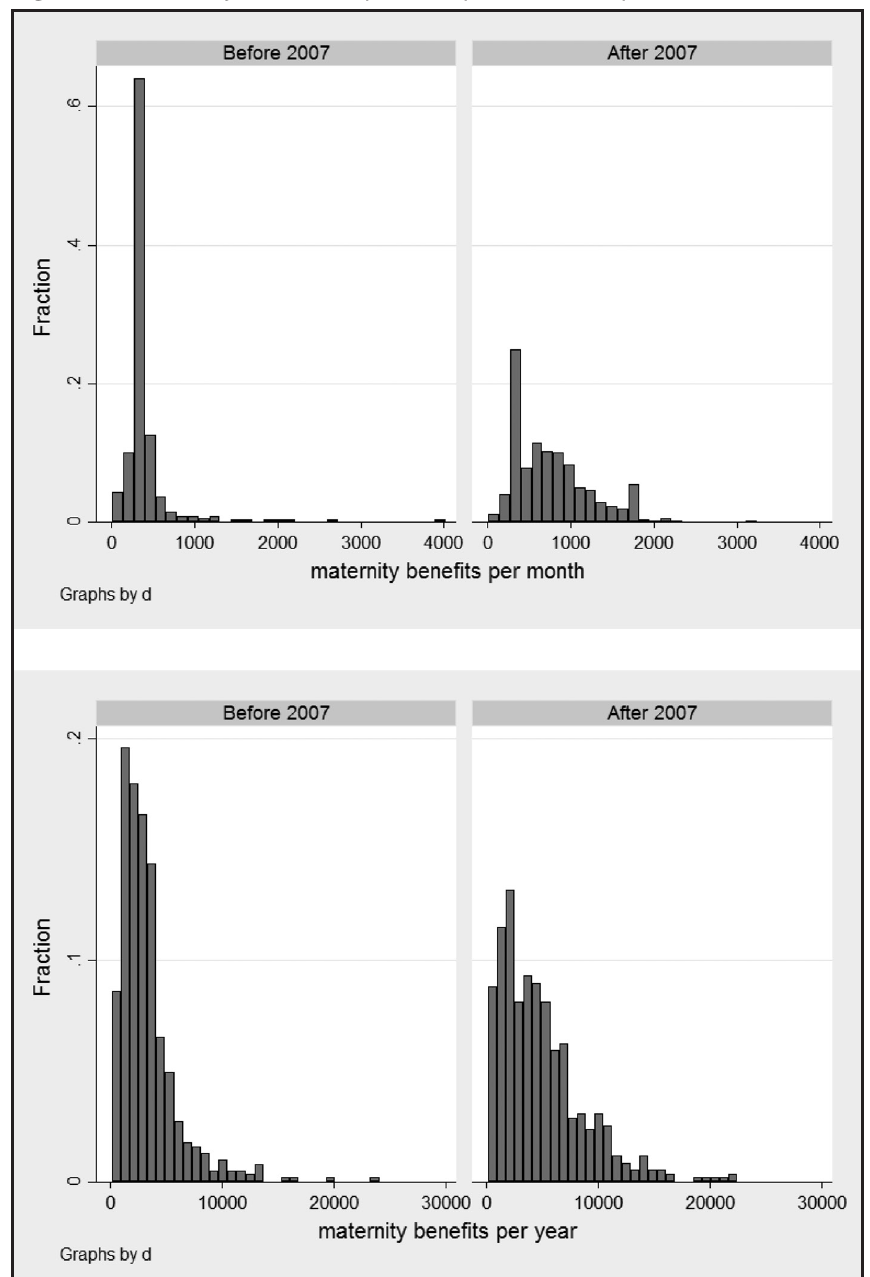
Figure 4 Maternity benefits in pre- and postreformed